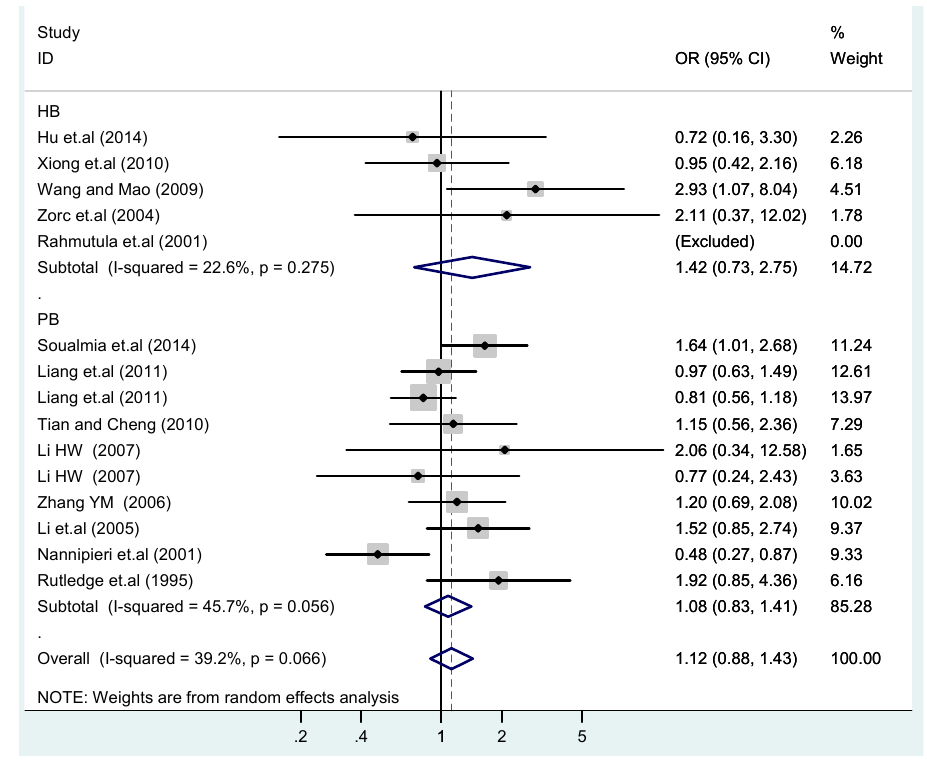
Figure 17. Subgroups in sources of controls of T2238C dominant model (CC + TC) vs. TT. Int. J. Environ. Res. Public Health 2016 , 13 , 458